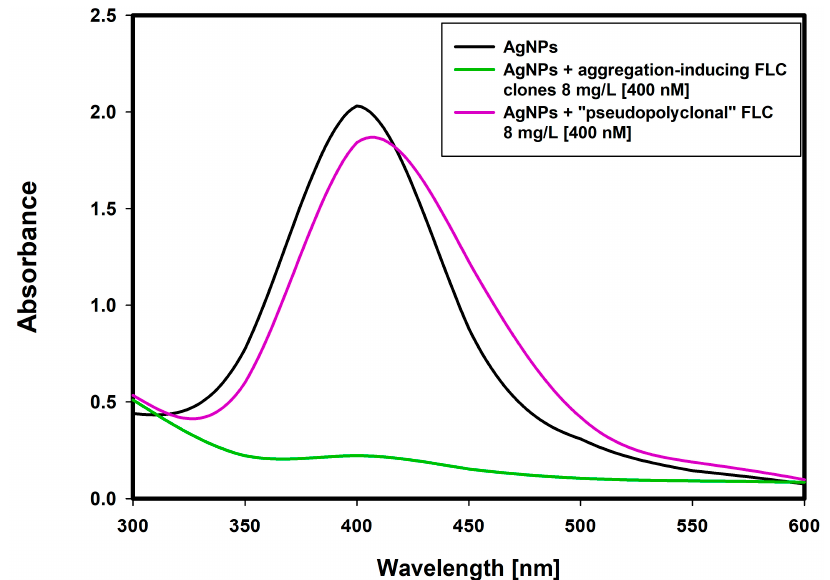
Figure 7. UV/Vis spectrum changes that occur after coating silver nanoparticles with free light chains (8 mg/L, (400nM)): aggregation-inducing free light chains clone (green line) and “pseudopolyclonal” free light chains (violet line). The "pseudopolyclonal" free light chains mixture does not cause aggregation of nanoparticles.